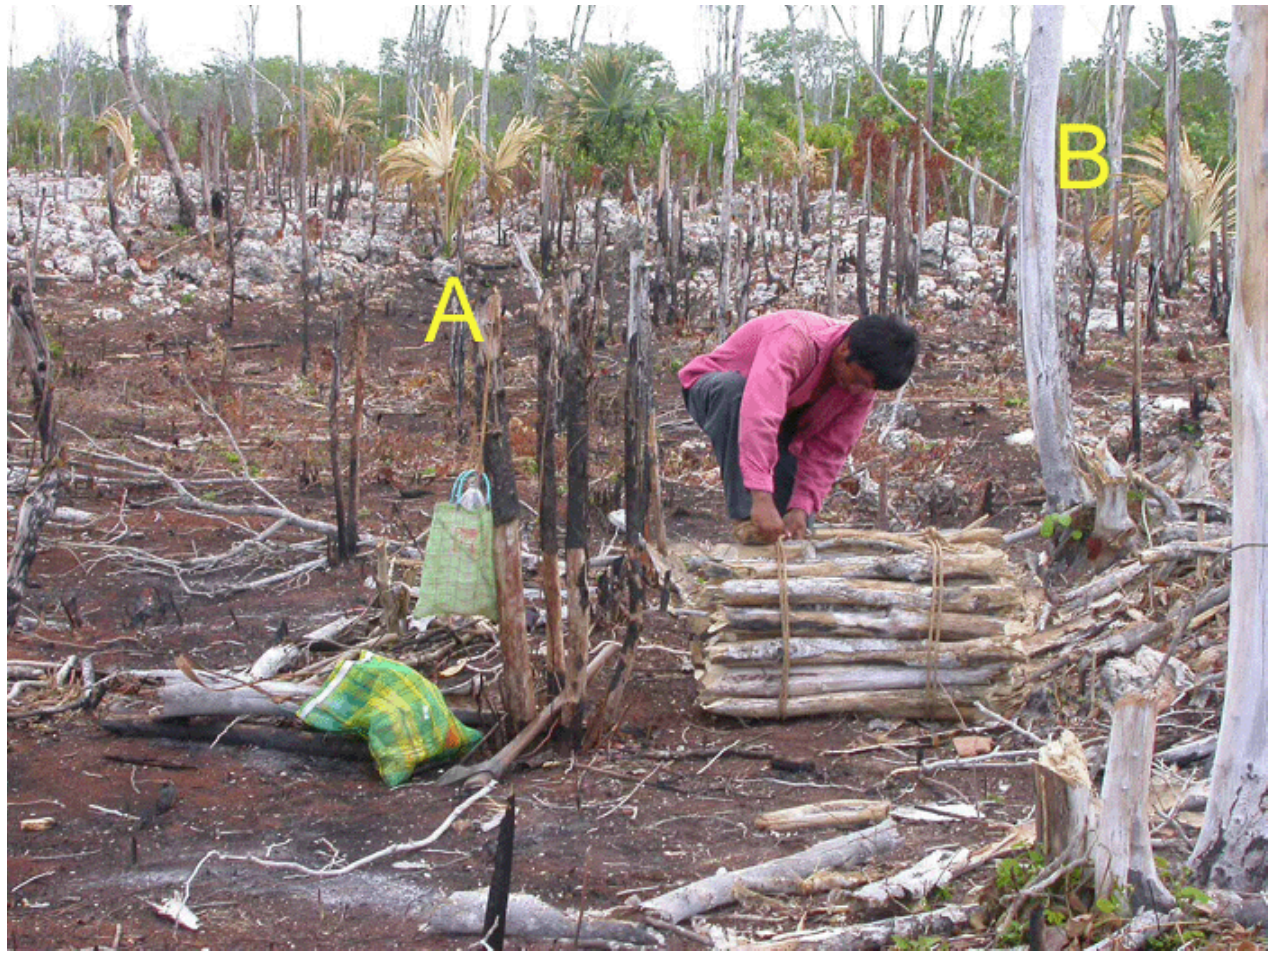
Fig. 2. Spared stumps (A) and trees (B) in a recently burned milpa. Don Brigido is preparing a load of firewood cut mostly from spared trees, seen at the bottom right of photograph. Two substrate types (Fig. 3) are also apparent: k’ankab in the foreground and wool wool tunich in the